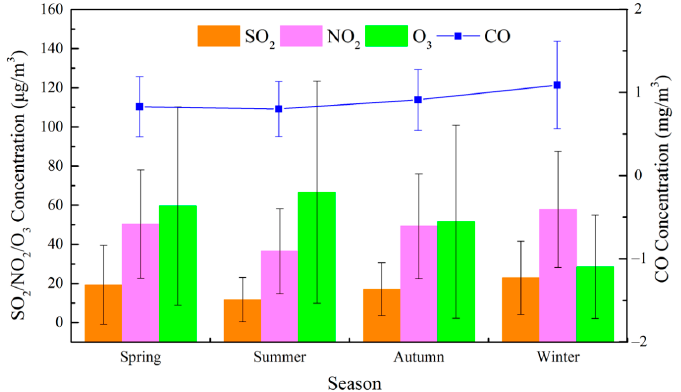
Figure 10. Seasonal variations of SO 2 , NO 2 , O 3 , and CO in Hangzhou City for 2014–2016.